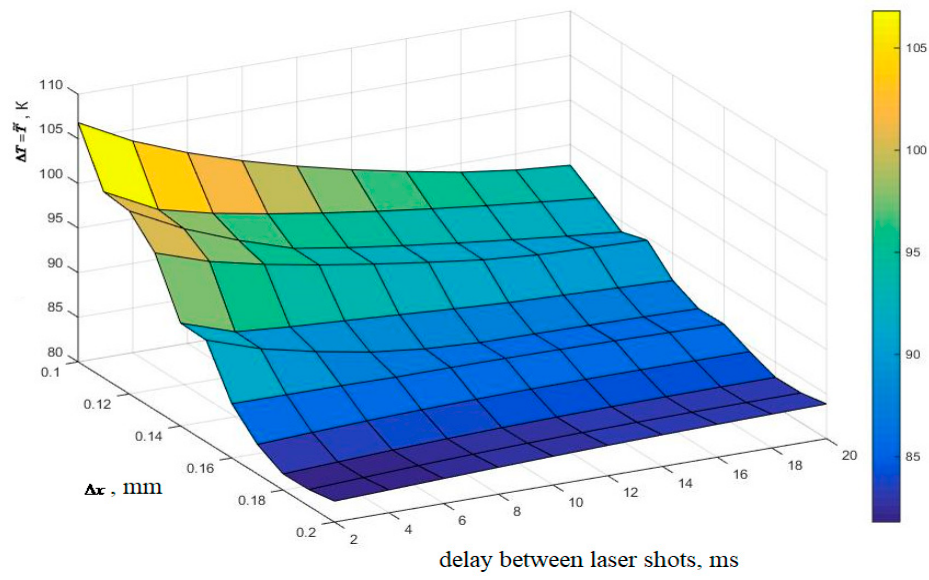
Figure 9. Dependence of the maximum temperature on the epithelial layer during the implementation of two shots on the delay between shots and the coordinates of the shots.